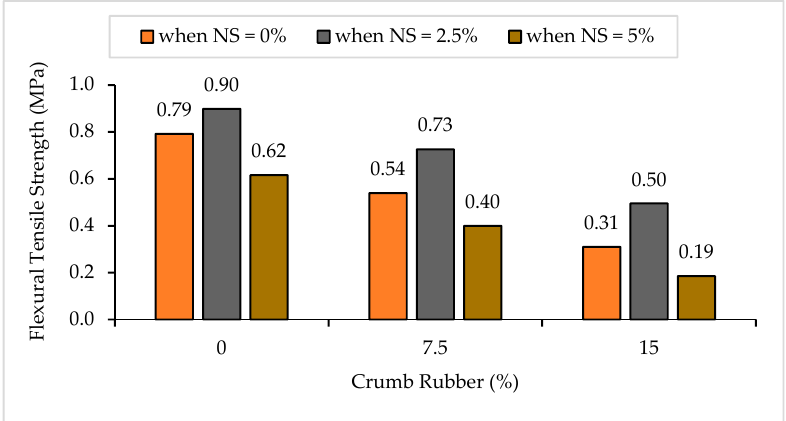
Figure 4. Flexural tensile strength of NS-CRM mixes at 28 days.